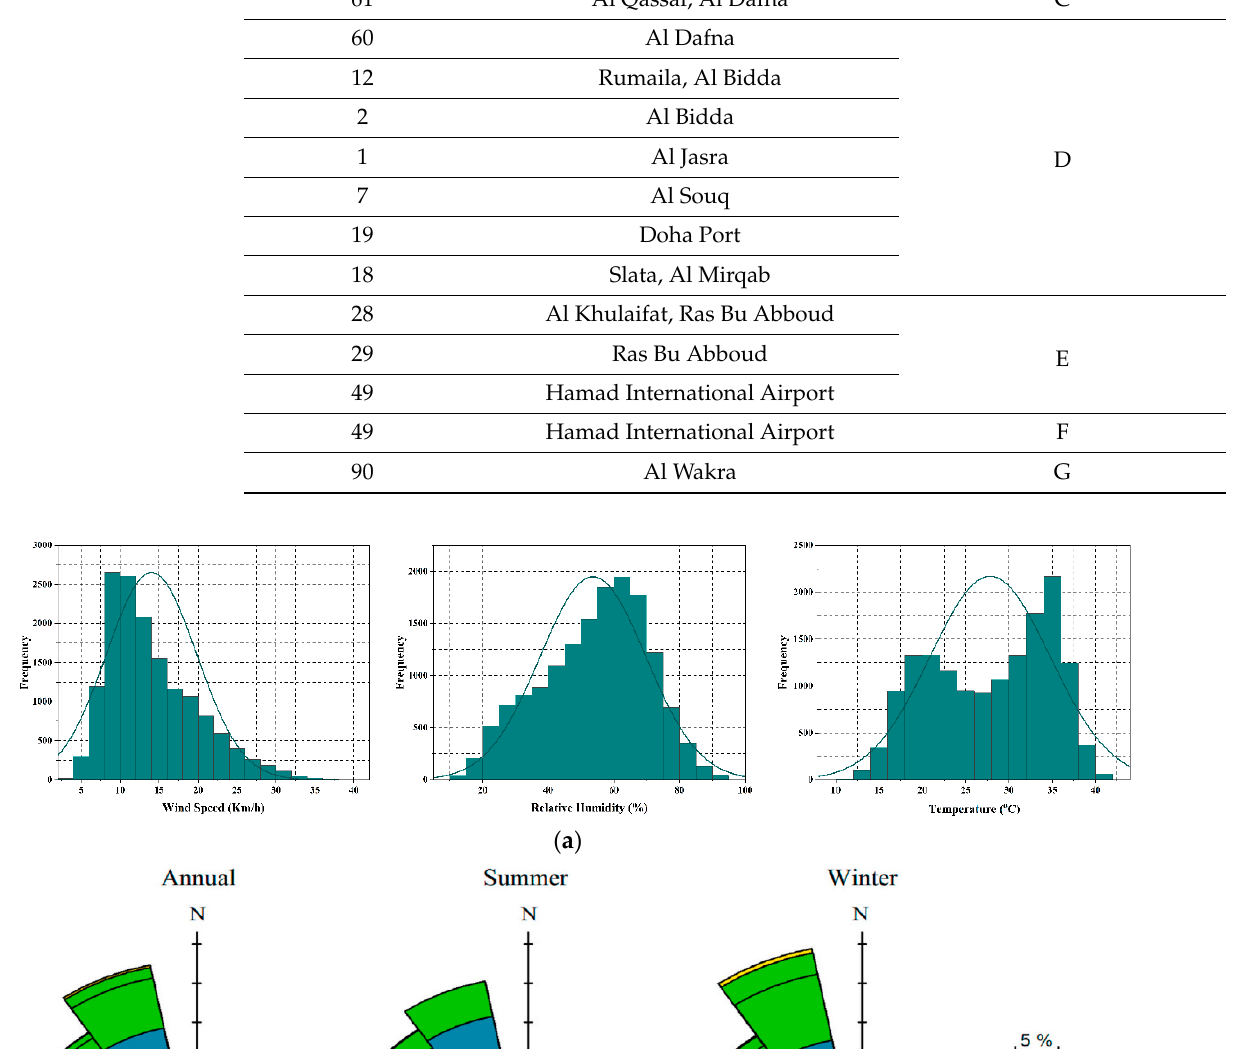
Table 1. Zone number and its allocated areas.